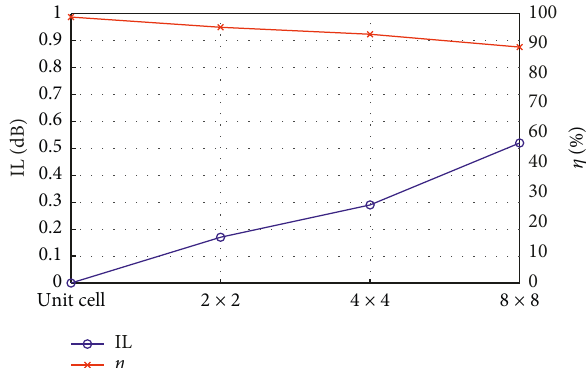
Figure 7: Simulated insertion loss and estimated overall efficiency of the presented array structure at 2.45GHz as a function of the metasurface array